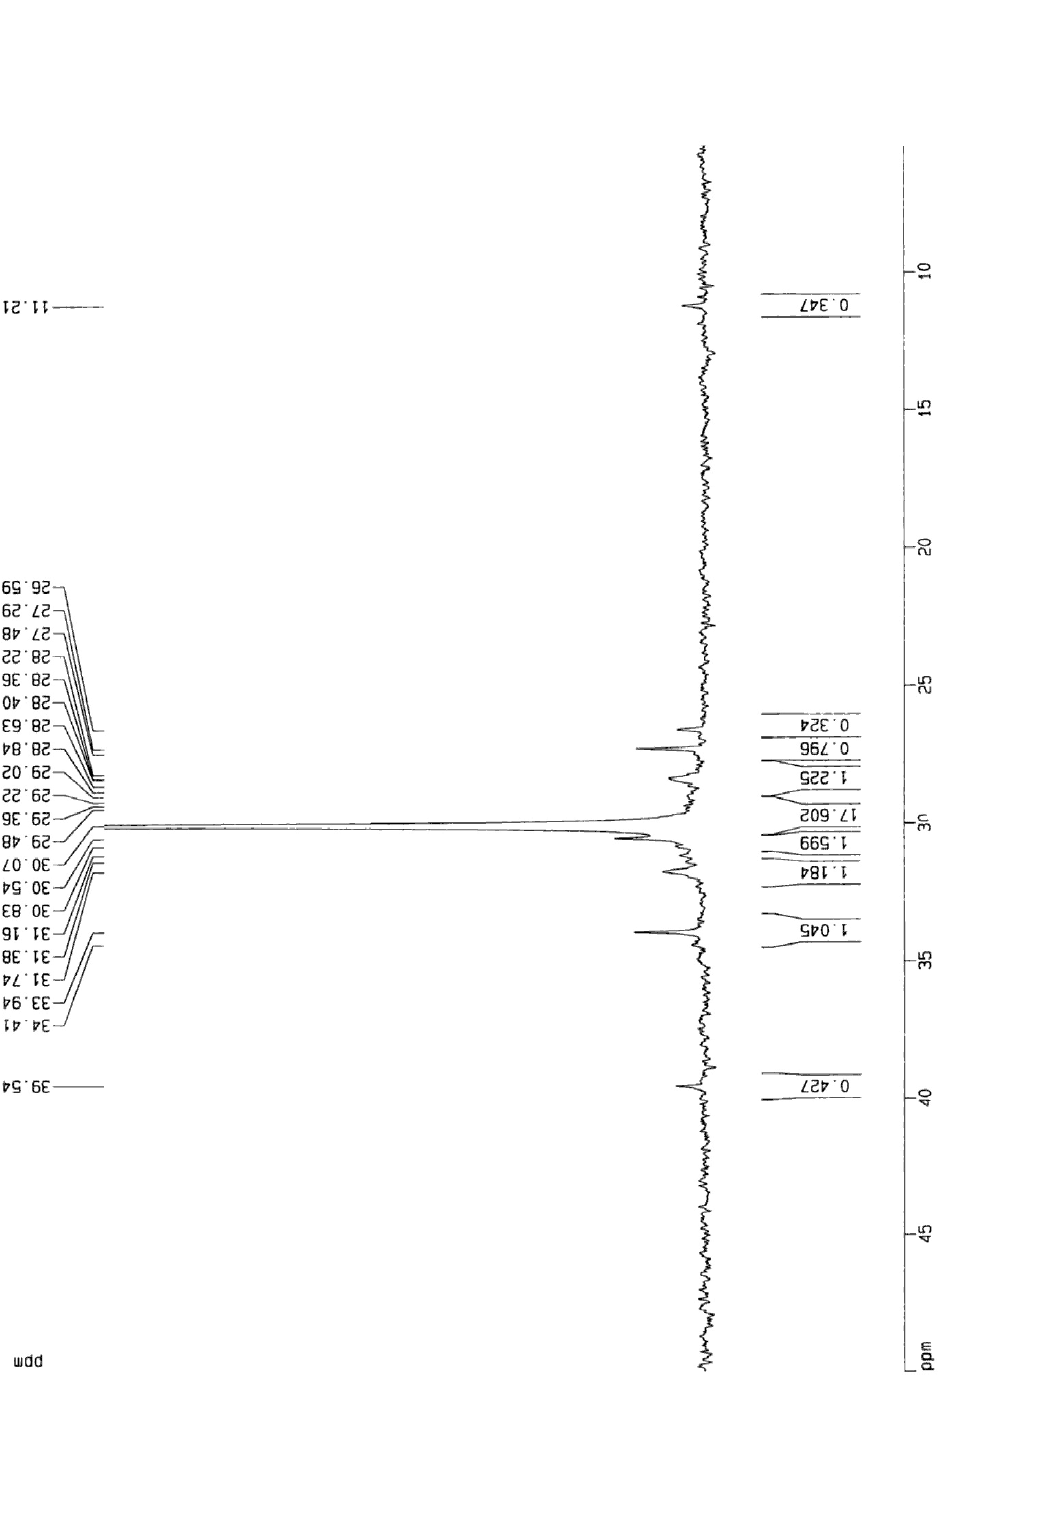
Fig. 3 13 C-NMR result of polyethylene (Entry